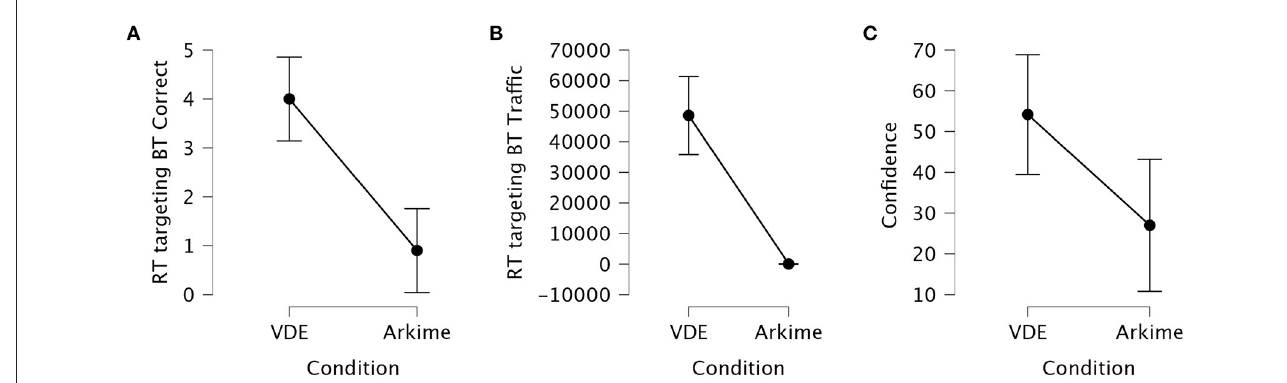
FIGURE5 Interval plots for the differences in identifying Red Team hosts targeting Blue Team systems. (A) Correctly identified Red Team hosts. (B) Traffic associated with correctly identified Red Team hosts. The number of sessions associated with correctly identified hosts ranged from 27,083 to 75,554 in the VDE group while ranging from 0 to 254 in the Arkime group. (C) Confidence in answers. Whiskers are 95% confidence intervals.